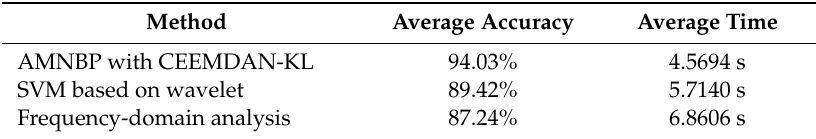
Table 5. Accuracy and e ffi ciency comparisons between the di ff erent